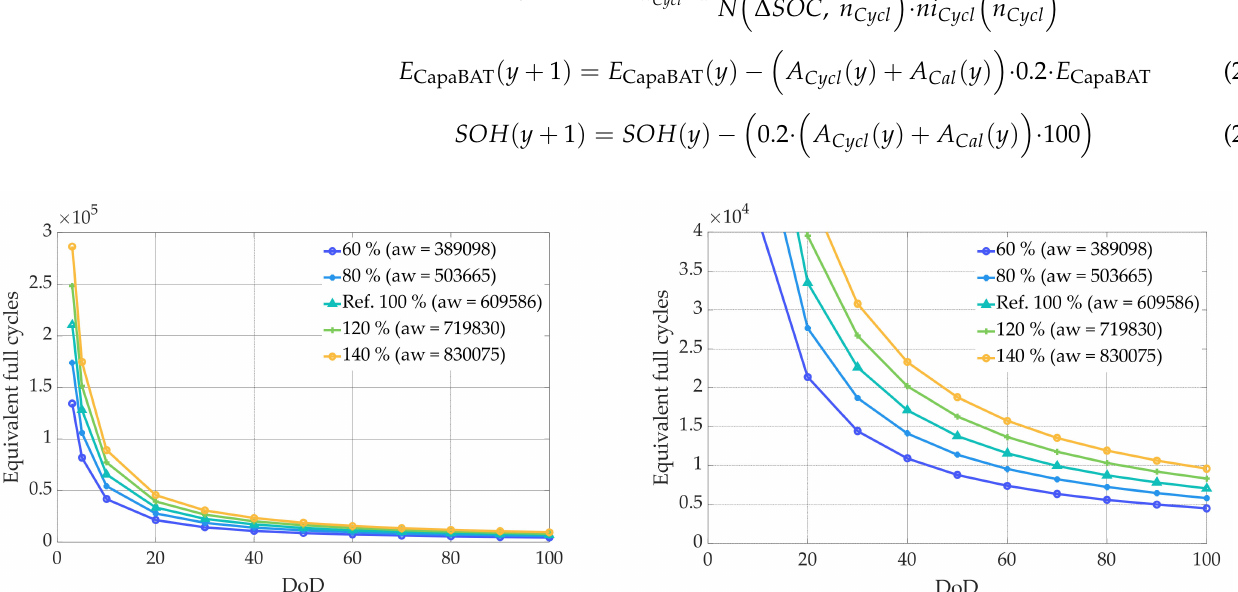
Figure 8. Scaled Wöhler curves based on the Wöhler curve presented in Angenendt et al. of the LG ICR18650MF1 lithium-ion battery cell [3]. aw for all presented curves is − 0.968423. The right panel shows a section of the left